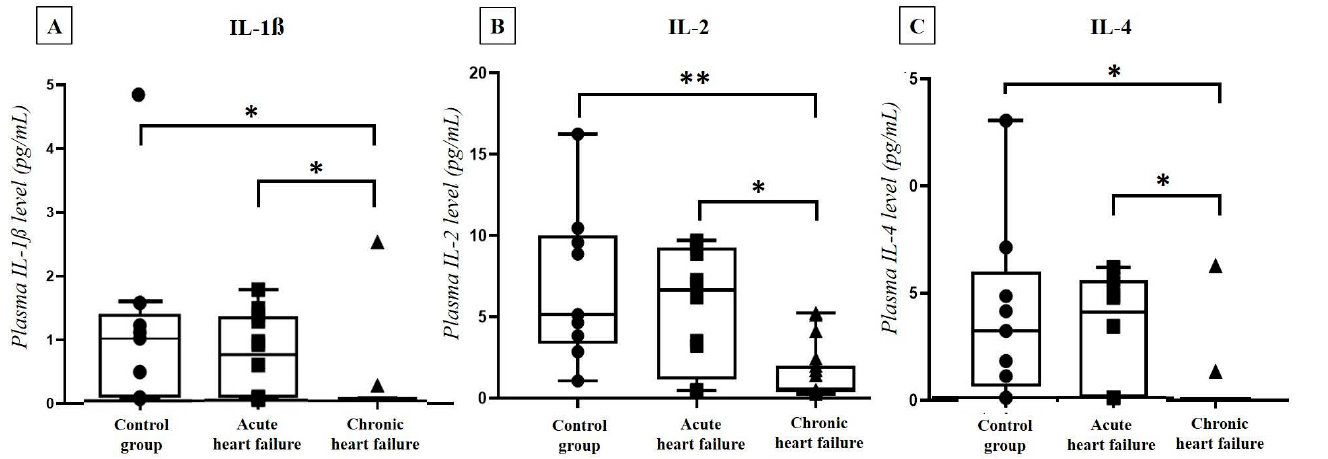
Figure 4. IL-1 β ( A ), IL-2 ( B ) and IL-4 ( C ) levels in acute ( n = 12) and chronic heart failure ( n = 19) patients and in the control group ( n = 9). Boxes with lines and whiskers represent the interquartile range, median values and the outliers. The individual values are presented with black dots (control group), squares (acute HF) or triangles (chronic HF). Statistical analysis was performed with one-way ANOVA test with Tukey post-hoc test. * p < 0.05, ** p < 0.001 vs. chronic heart failure group. In addition, significantly ( p = 0.038) higher IL-10 levels were detected in the acute HF group compared to the control, but not to the chronic HF group (Figure 5). In contrast, we did not detect any significant differences between the HF and control groups regarding IL-6, IFN- γ and TNF- α